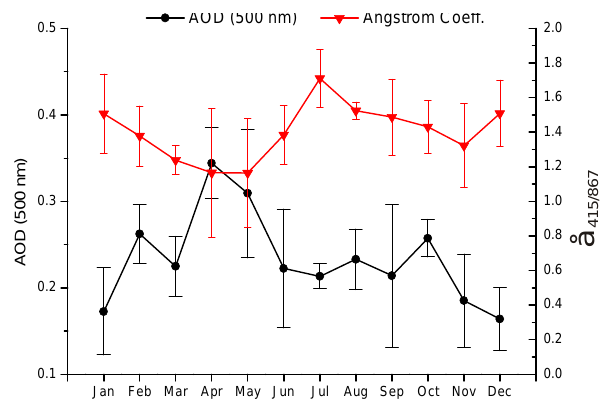
Fig. 4. Annual cycles of AOD at 500nm and the ˚Angstr¨om co- efficient. Values are calculated as averages of daily means for each Figure 4. Annual cycles of AOD at 500 nm and the Ångström coefficient. Values are month for the period 2006–2008 and the bars are the respective stan- dard calculated as averages of daily means for each month for the period 2006-2008 and the bars are the respective standard deviations.